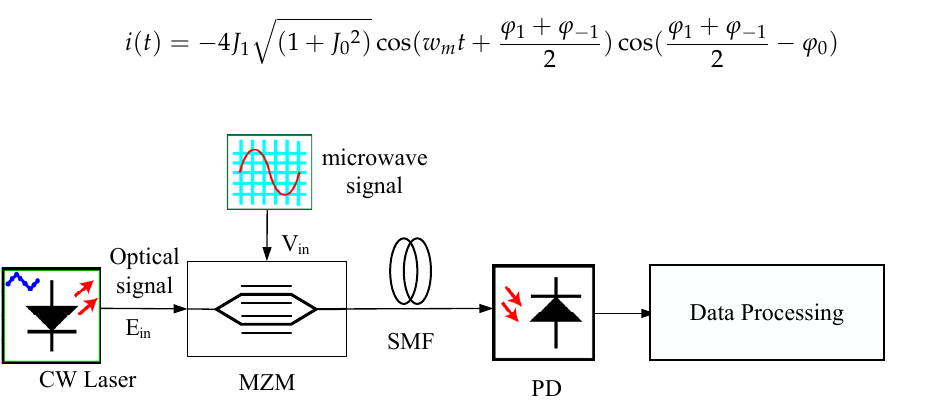
Figure 1. Structure diagram of IFM method. CW laser: continuous-wave laser; MZM: Mach–Zehnder modulator; SMF: single-mode fiber; PD: photodetector.